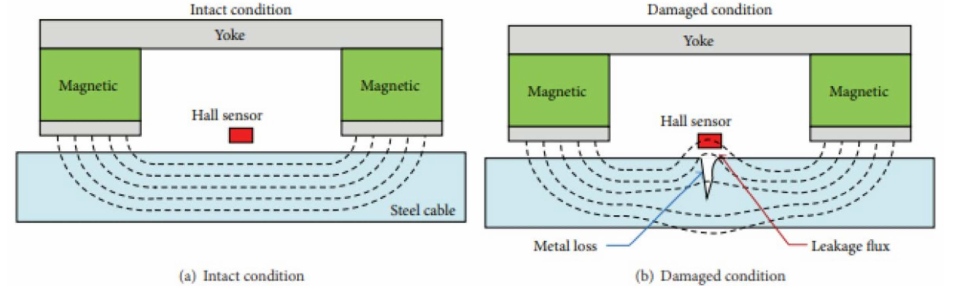
Figure 23. The methodology of MFL non-destructive testing method [28].